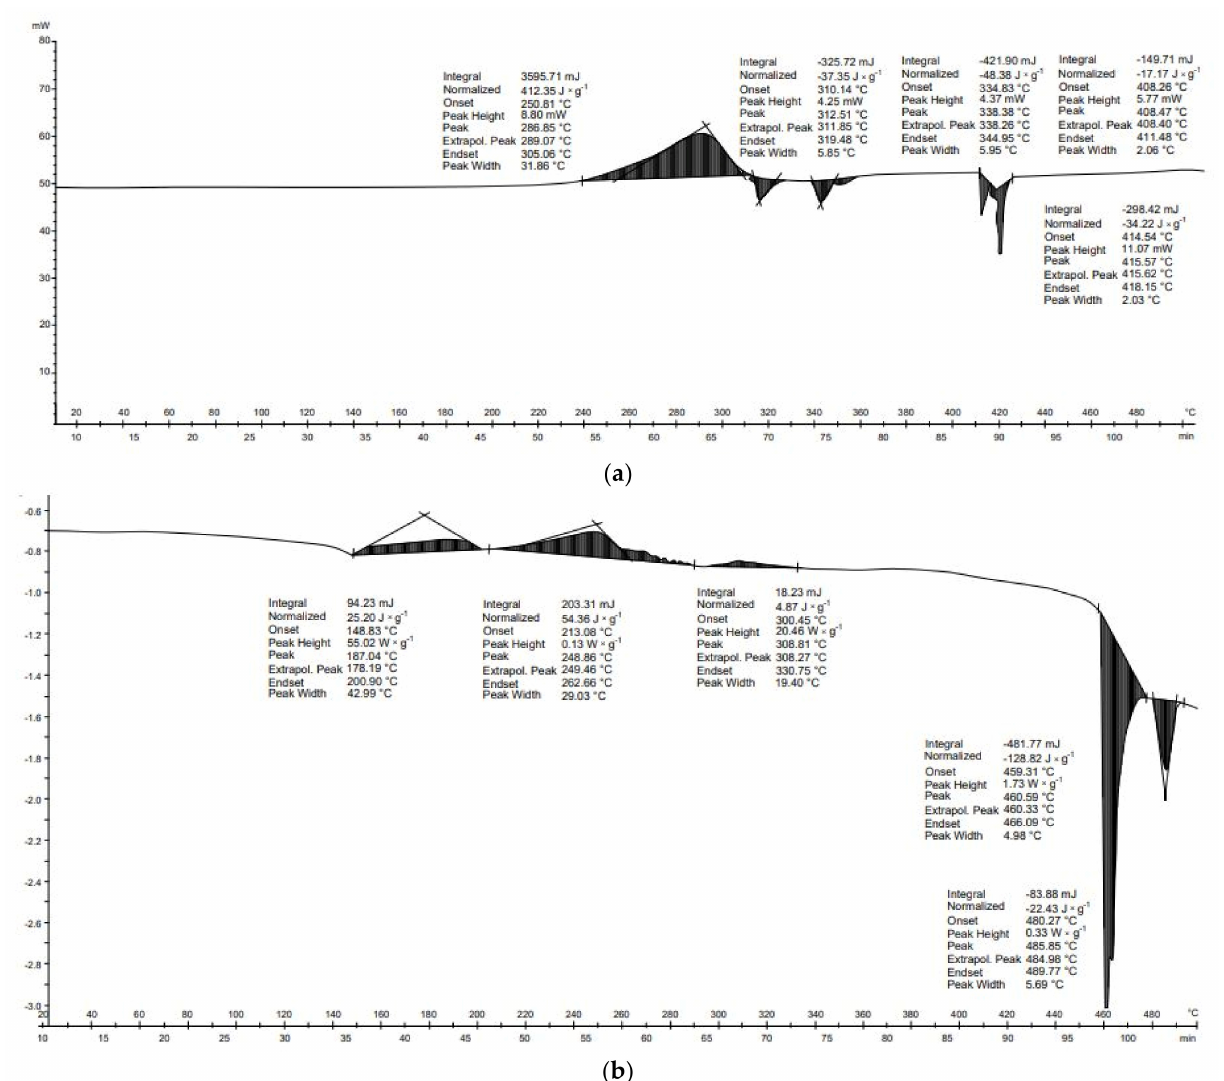
Figure 6. Characteristics of the DSC of textile waste: ( a ) cotton textile; ( b )